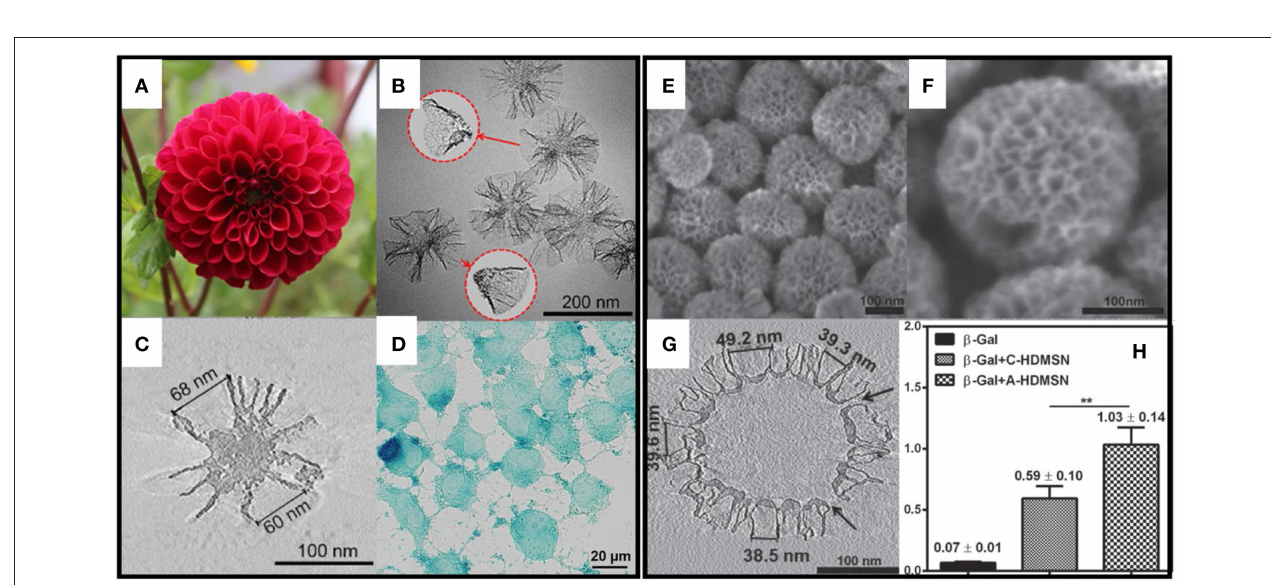
FIGURE 1 | Enhanced stability and activity of lysozyme after loaded inside the mesopores of MSNs. Schematic illustration (A) showed the relative activity of lysozyme loaded into MSNs was 4.4-folds higher than that loaded on the outer surface of solid silica nanoparticles (SSN). (B,C) showed the pore structure of MSNs and (D) showed the circular dichroism (CD) spectrum of free lysozyme and the one loaded inside MSNs. Reproduced with permission from Kao et al. (2014), The American Chemical Society.